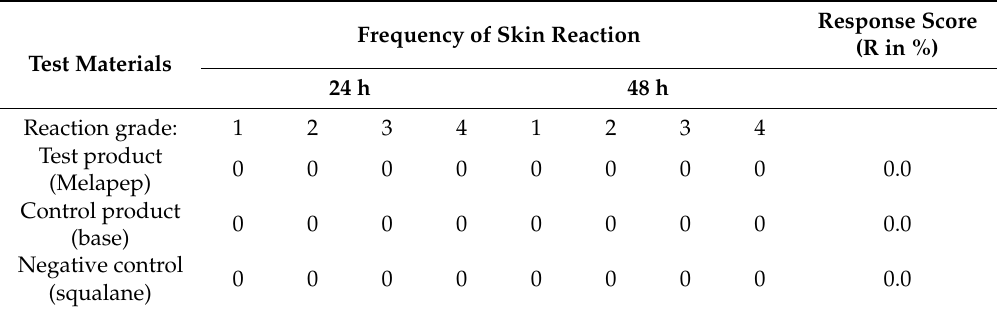
Table 2. Results of primary human skin irritation test ( n =